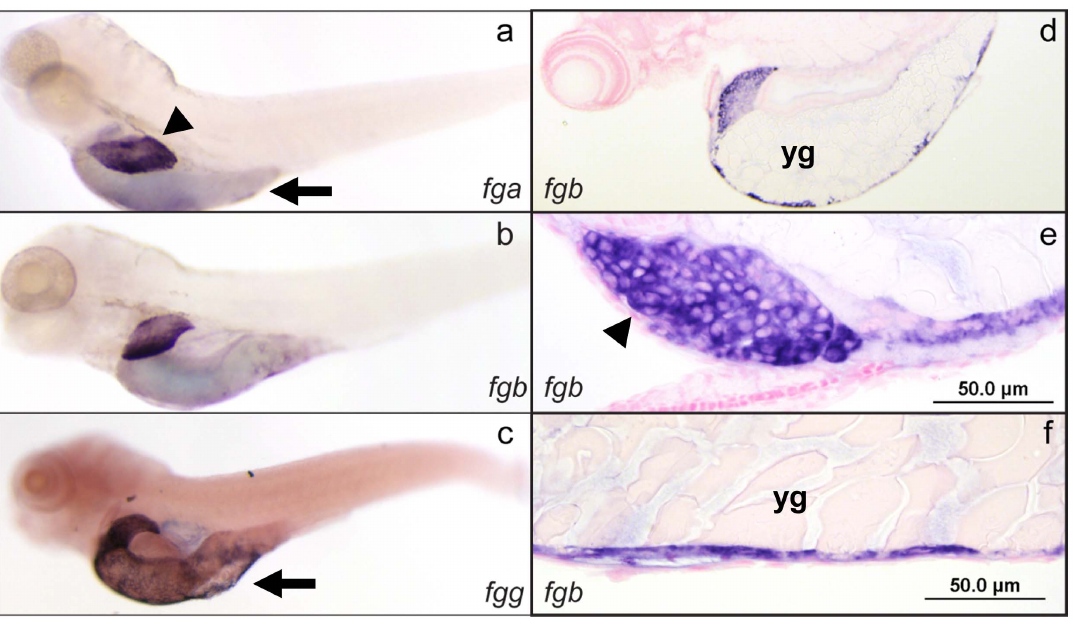
Figure 1. Insitu hybridization of zebrafish fibrinogen genes demonstrates liver and yolk sac specific expression. Whole mount in situ hybridization was performed using antisense mRNA probes complementary to the fga , fgb , and fgg mRNAs (a, b, and c respectively) at 5 dpf. The expression patterns were identical, with high levels in the liver and yolk sac. Individual experiments showed variability in yolk sac expression for all 3 genes, e.g. lower (a, b) and higher (c) levels of expression. Sections through fgb probed larvae confirmed that liver expression was in hepatocytes, while the yolk sac staining was in the outer cellular layer (d–f). Arrowheads indicate the liver, while arrows point to the yolk sac; yg, yolk granules. Sections of fga and fgg probed larvae demonstrated the same pattern, while in situ hybridization with probes generated from the sense strand did not show any signal (not shown).